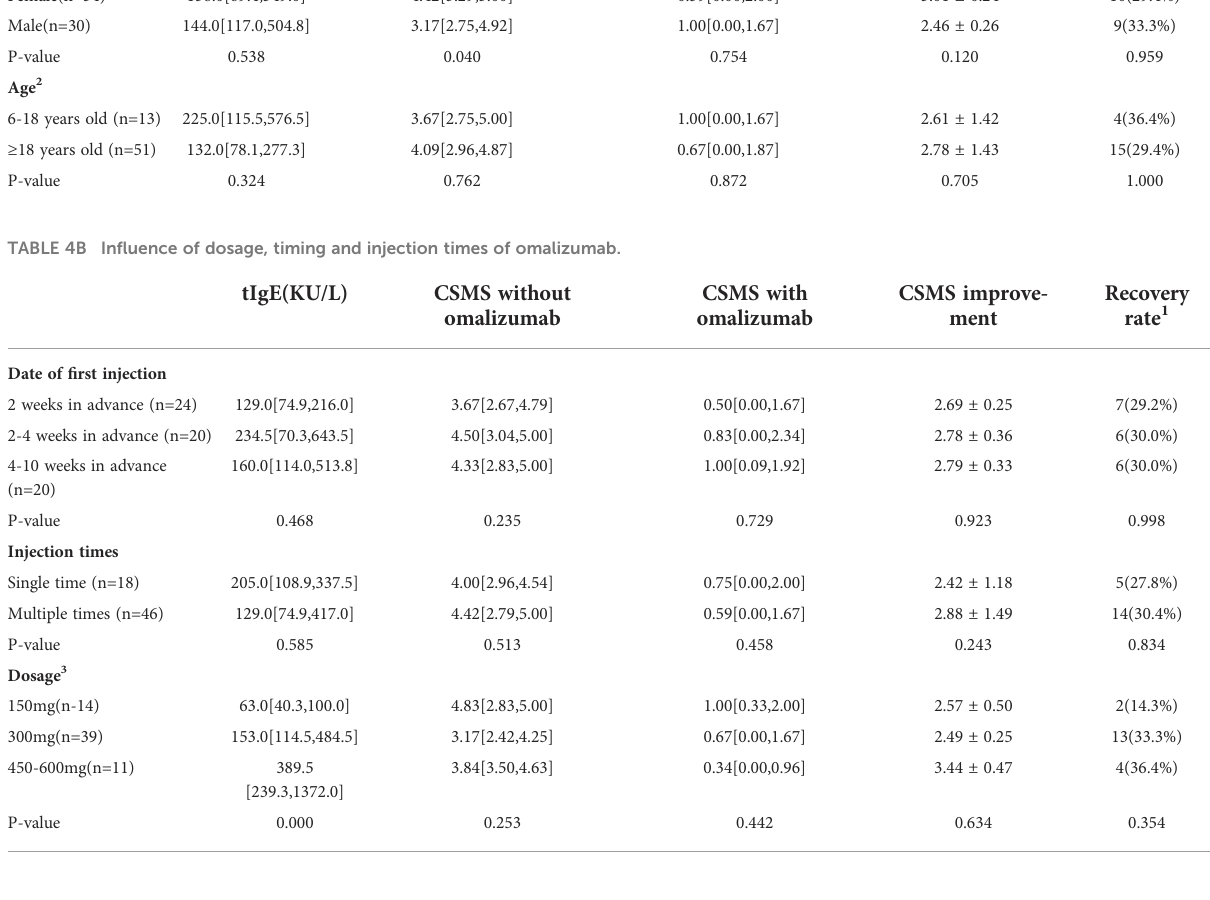
TABLE 4C In fl uence of complicated allergy.